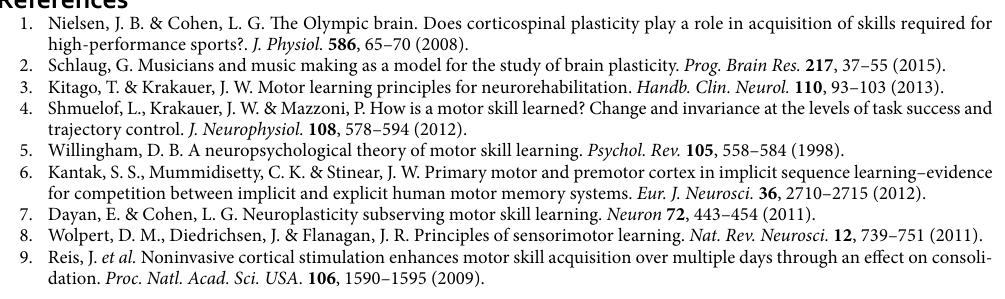
Fig. 2. Online gain scores were calculated for each training day representing within-day learning as the difference between first and last learning trial accuracy (t20–t1), while offline gain scores were calculated between training days analog to 9 to investigate between-day consolidation